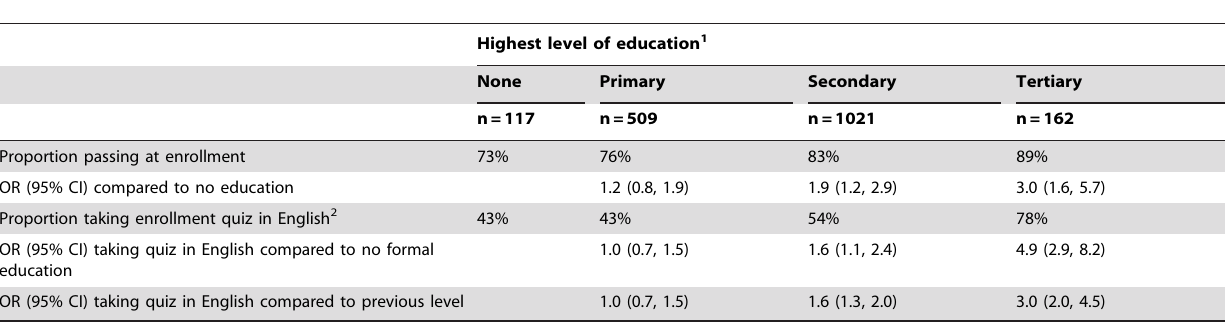
Table 4. Odds of passing quiz 1 by highest level of education; odds of taking quiz 1 in English by highest level of education.